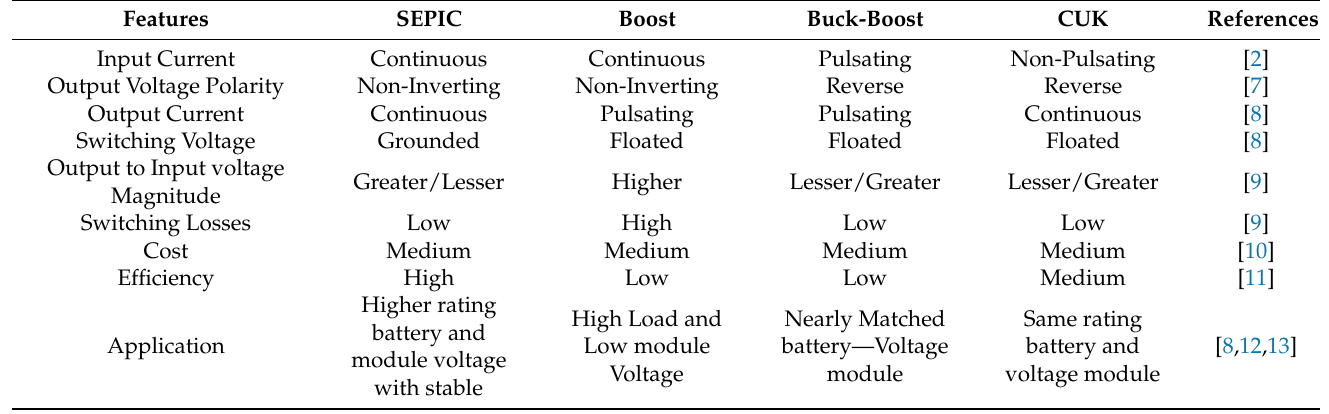
Table 4. Comparison of Different Types of Converter.